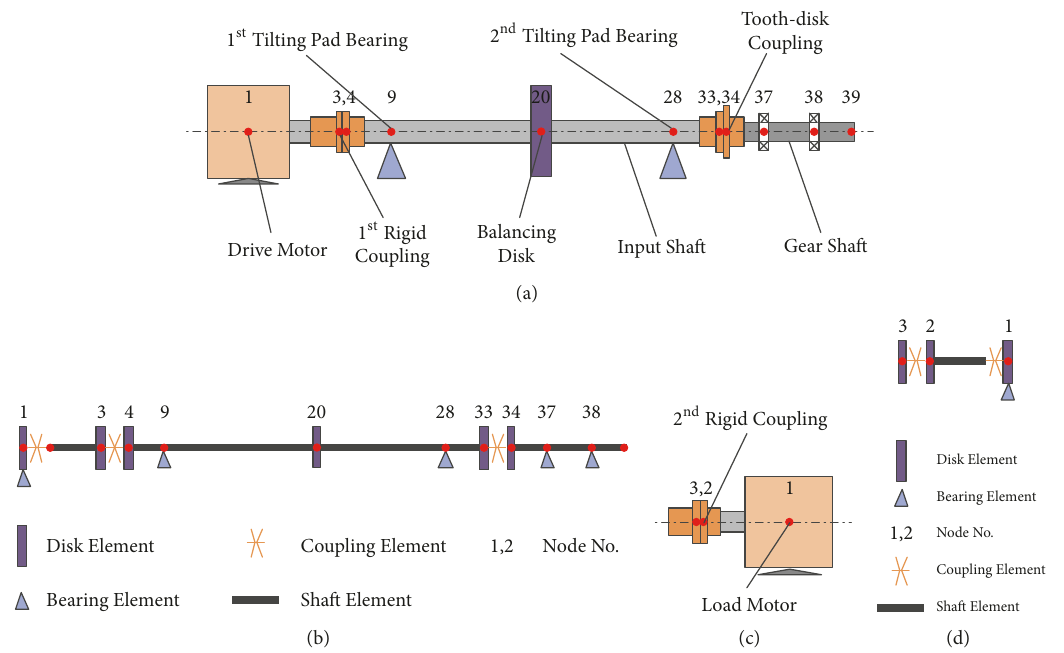
Figure 6: Model of external rotor subsystem: (a) schematic of input rotor subsystem, (b) finite element model of input rotor subsystem, (c) schematic of output rotor subsystem, and (d) finite element model of output rotor subsystem.